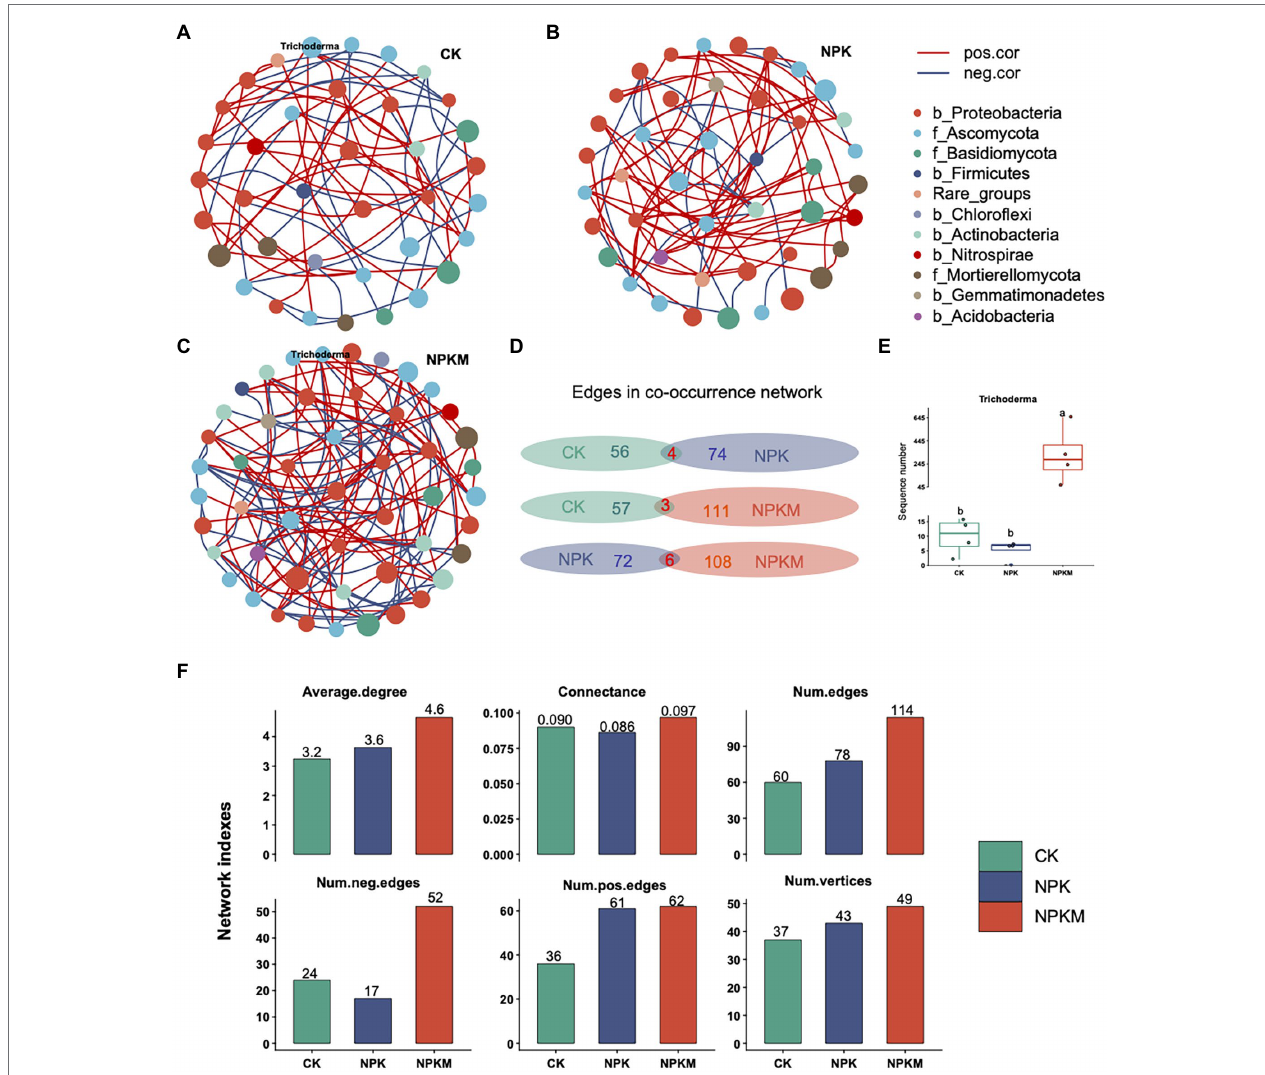
FIGURE 6 | Co-occurrence networks of bacterial and fungal communities in (A) control (CK), (B) nitrogen–phosphorus–potassium (NPK), and (C) , NPK plus organic fertilizer (NPKM) fertilization treatments. Each node in a network represents a genus of bacteria or fungi. Size of a node represents average relative abundance of a genus of bacteria or fungi. Different colors of nodes provide taxonomic information at the phylum-level. In the legend, names of bacterial phyla begin with “b,” and names of fungal phyla begin with “f.” (D) Common and unique edges in co-occurrence networks between each two of the three treatments. (E) Comparison of sequence numbers of the fungus Trichoderma in different fertilization treatments. (F) Indices related to topological structure of the co-occurrence interaction network of bacterial–fungal